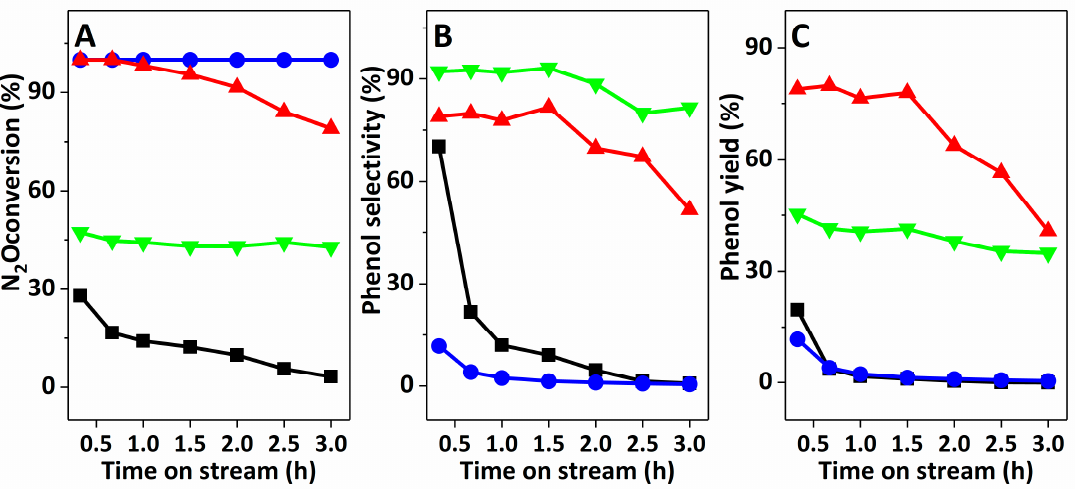
Figure 7. Effect of time on stream on ( A ) N 2 O conversion, ( B ) phenol selectivity and ( C ) yield over (a)